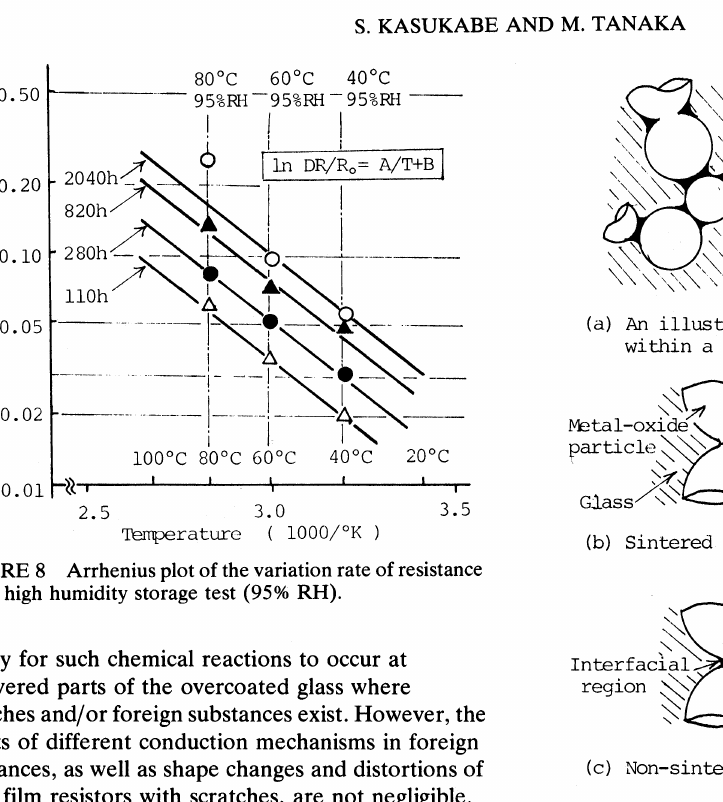
FIGURE 9 Schematic structure of thick film